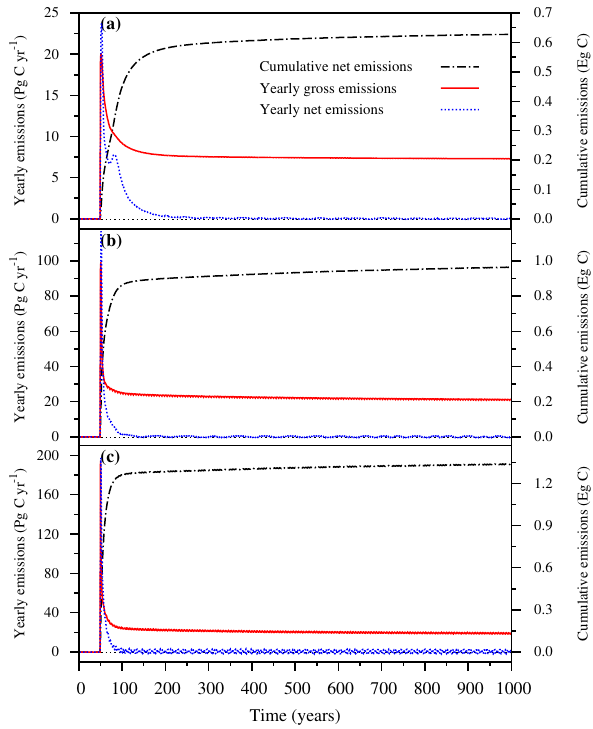
Figure 6. Yearly (both gross and net; left axis) and cumulative (right axis; 1EgC = 1000PgC) carbon emissions for the stable fire regimes. The onset of fire activity happened in year 0, after which fire frequency remained constant. (a) Fire20S. (b) Fire100S. (c) Fire200S.